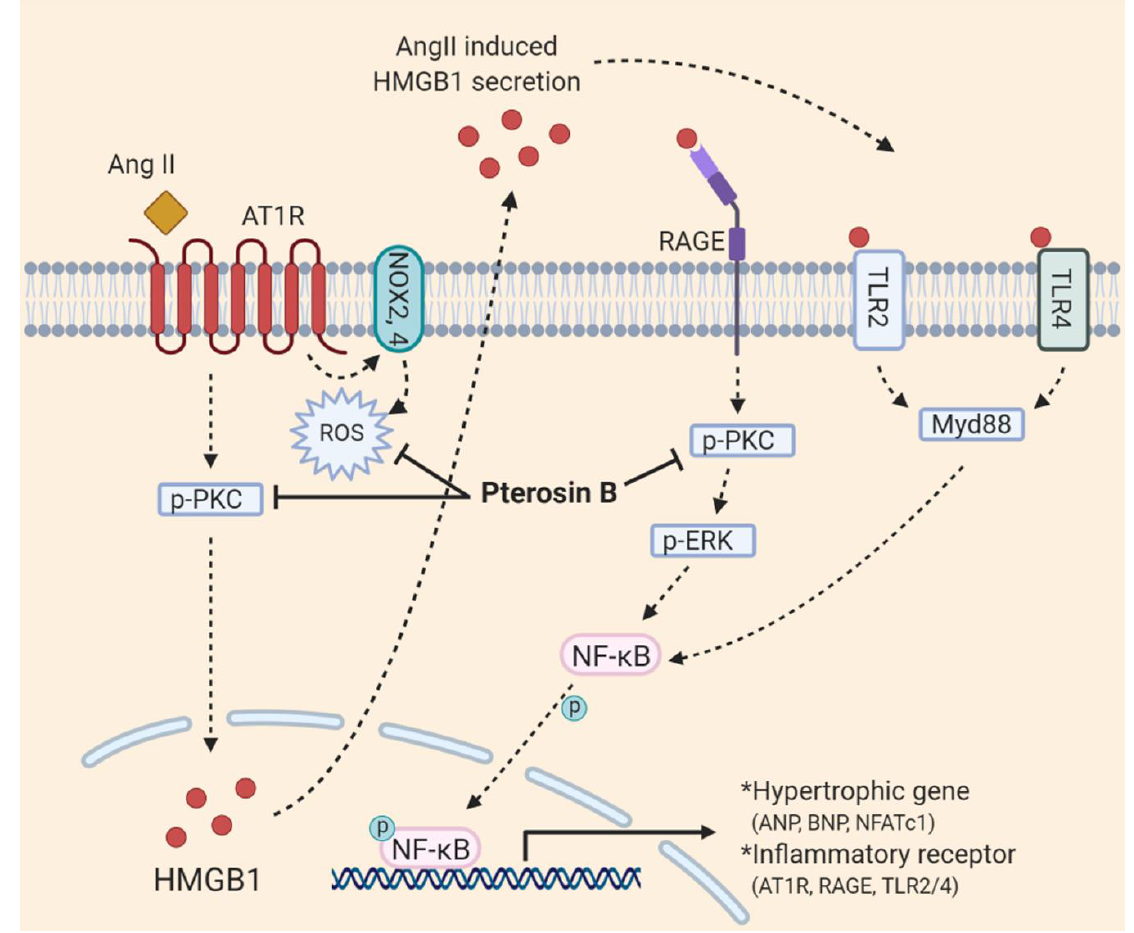
Figure 6. Schematic diagram with roles of Pterosin B in Ang II-induced cardiomyocyte hypertrophy.